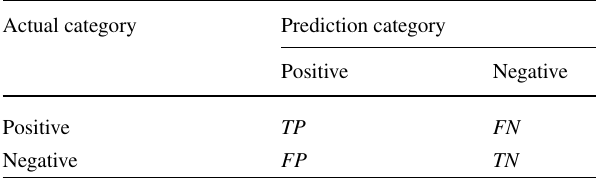
Table 5 Confusion matrix of classification results Actual